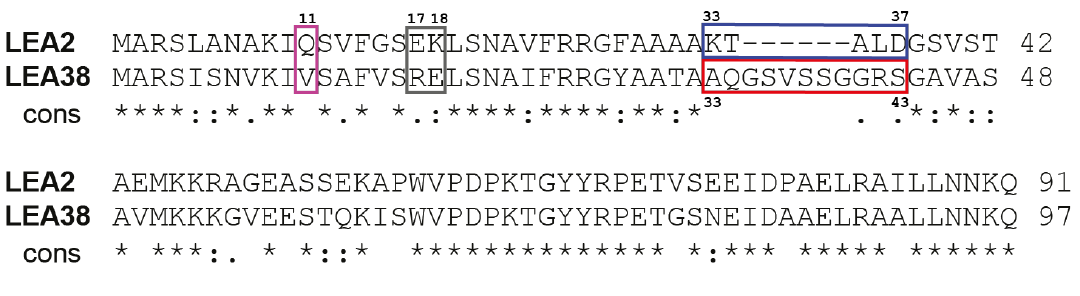
Figure 2. Comparison of LEA2 and LEA38 protein sequences. Amino acid alignment was performed with LALIGN. The degree of similarity between amino acids occupying the same position is indicated by the following symbols: “*” identity; “:” strong similarity; “.” weak similarity. Sequence differences selected to generate mutated LEA2 proteins are indicated by colored boxes.